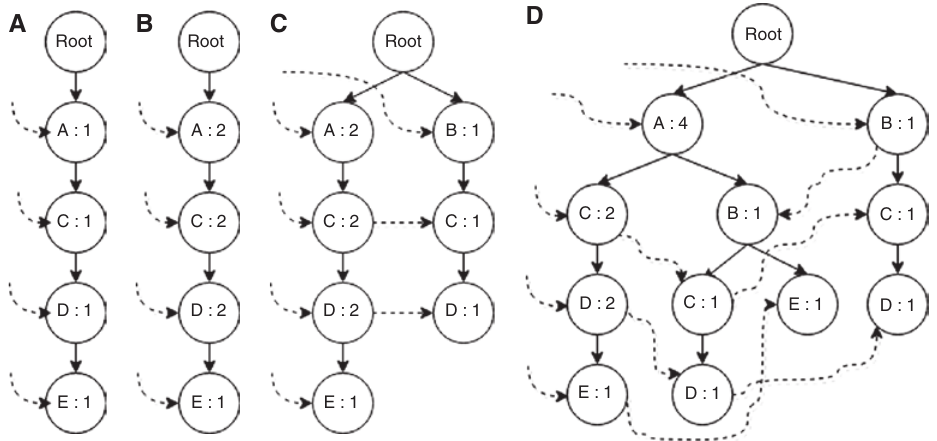
Figure 2: T-index Construction Steps for Database in Table 1.